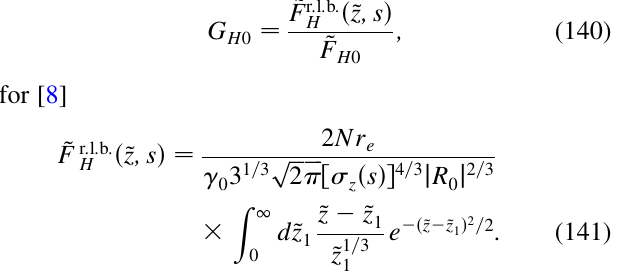
FIG. 3. (Color) Model chicane: R (cid:1) 1 m , L